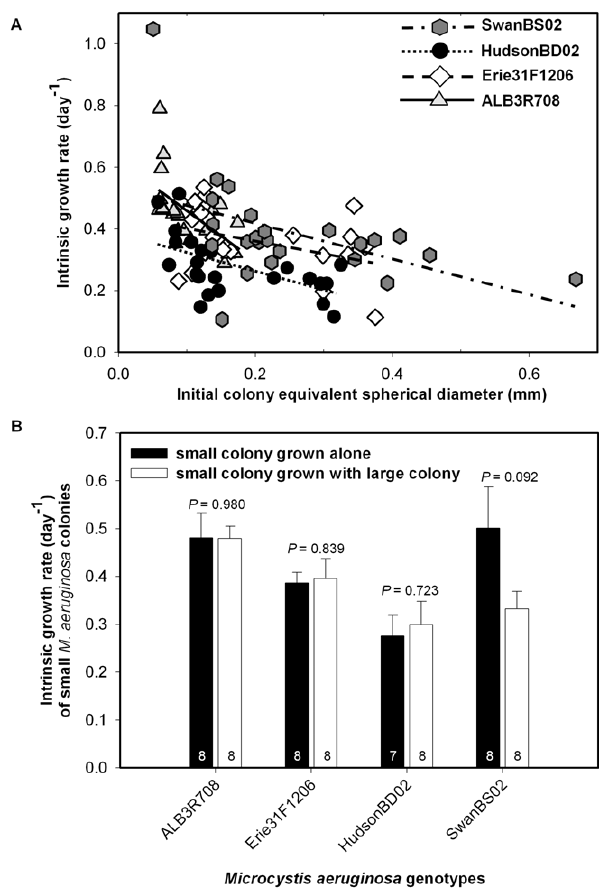
Figure 3. Test of colony resource exhaustion. (A) Relationship between growth rate (day 2 1 ) and initial colony equivalent spherical diameter (ESD, mm) between days 1 and 7 for individual colonies of four M. aeruginosa genotypes (ALB3R708, Erie31F1206, HudsonBD02, and SwanBS02). (B) Comparison of colony growth rates for small colonies of four M. aeruginosa genotypes grown in chambered slides in isolation (dark bars) or in association with a large colony of the same genotype (white bars). Error bars=1 standard error. Inset numbers are sample sizes.